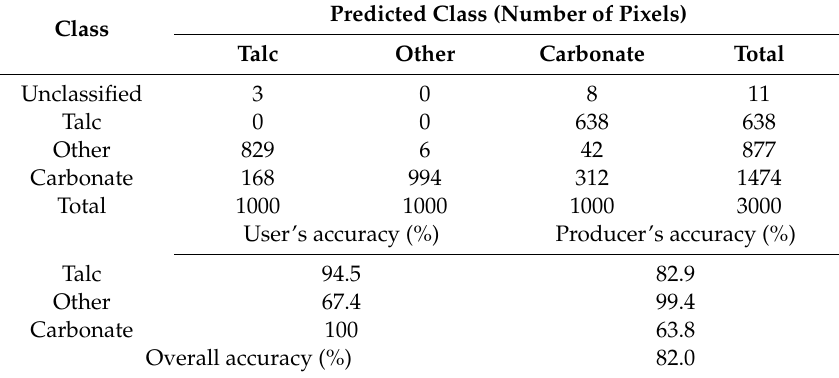
Table 5. A confusion matrix for the classification results of carbonate minerals, talc, and other types, by the band ratio